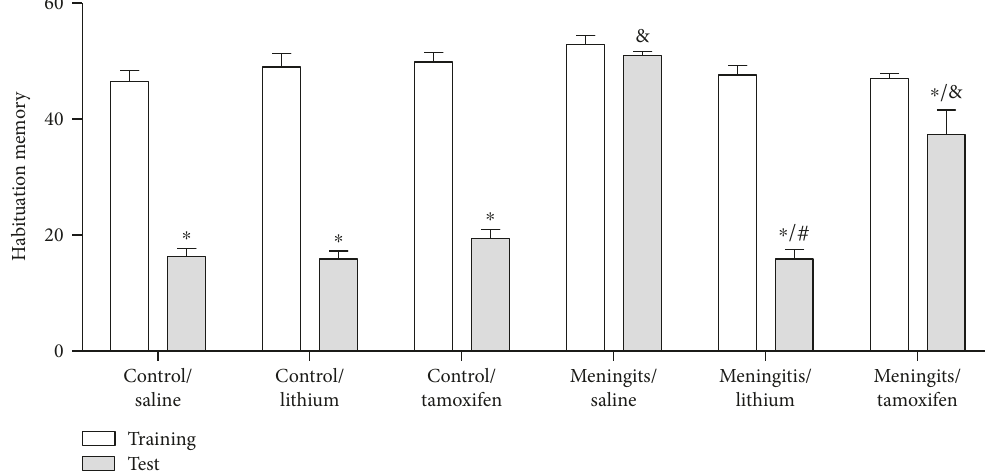
Figure 2: E ff ects of lithium and tamoxifen on habituation to open- fi eld task in adult Wistar rats 10 days after pneumococcal meningitis induction. The numbers of crossings and rearing movements are reported as the mean ± SD and were analyzed by ANOVA and post hoc Tukey ’ s tests ( n = 12 ). ∗ P < 0 05 statistically di ff erent from training session; & P < 0 05 di ff erent from control/saline group; and # P < 0 05 di ff erent from meningitis/saline group.